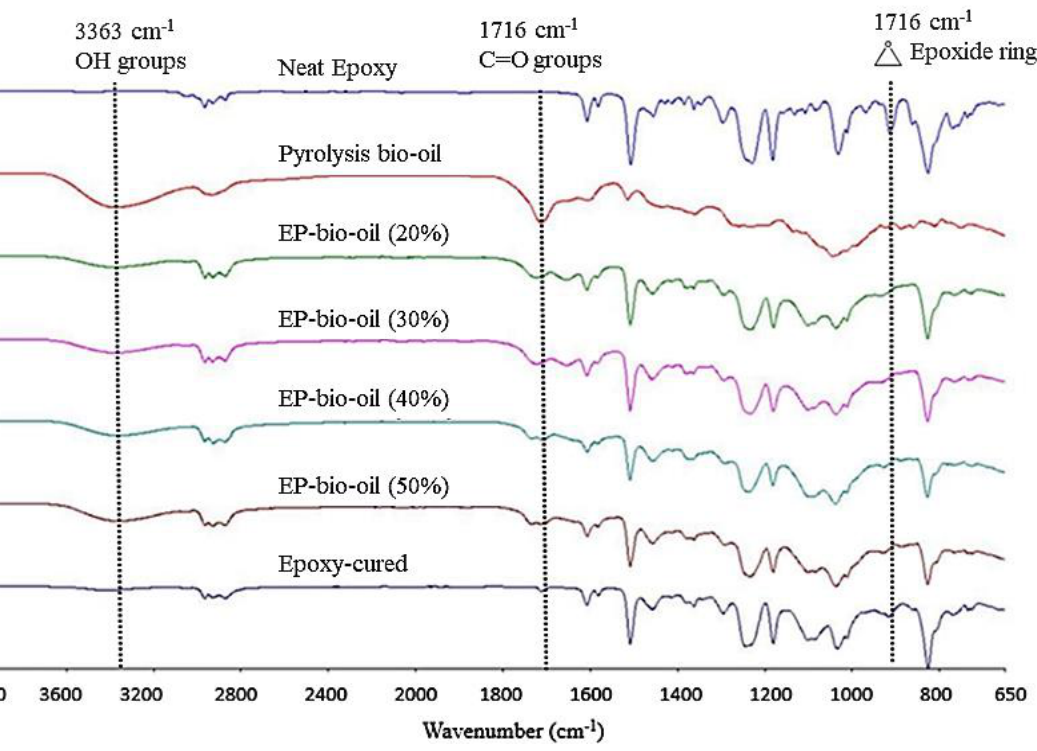
Figure 2. FTIR spectra of fast pyrolysis bio-oil, neat epoxy resin (Epon 828), cured epoxy, and epoxy-substituted bio-oil at different bio-oil contents (EP-bio-oil).